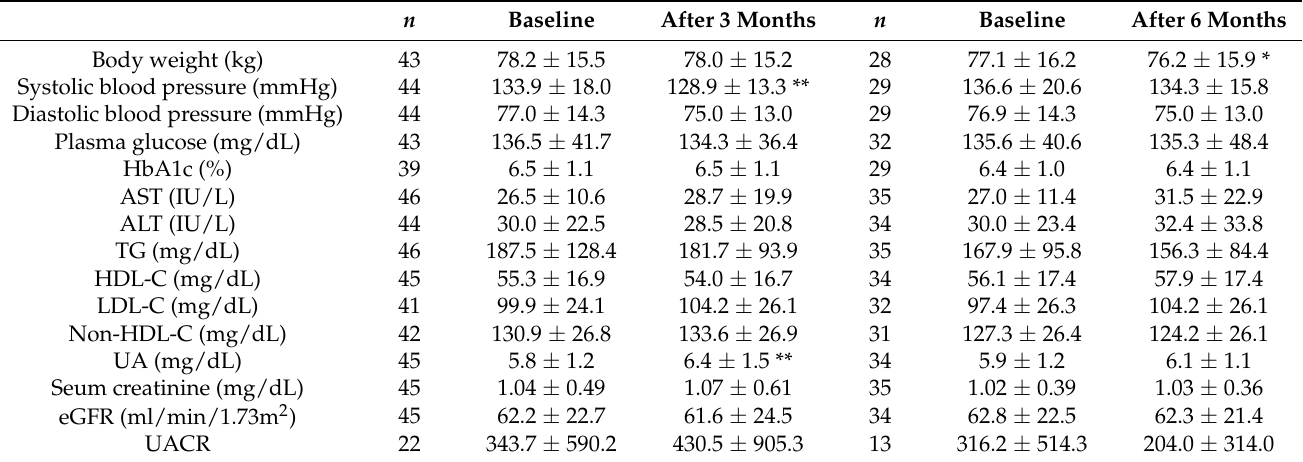
Table 5. Changes in metabolic parameters after the strart of dotinurad in patients who switched from xanthine oxidase inhibitors ( n =